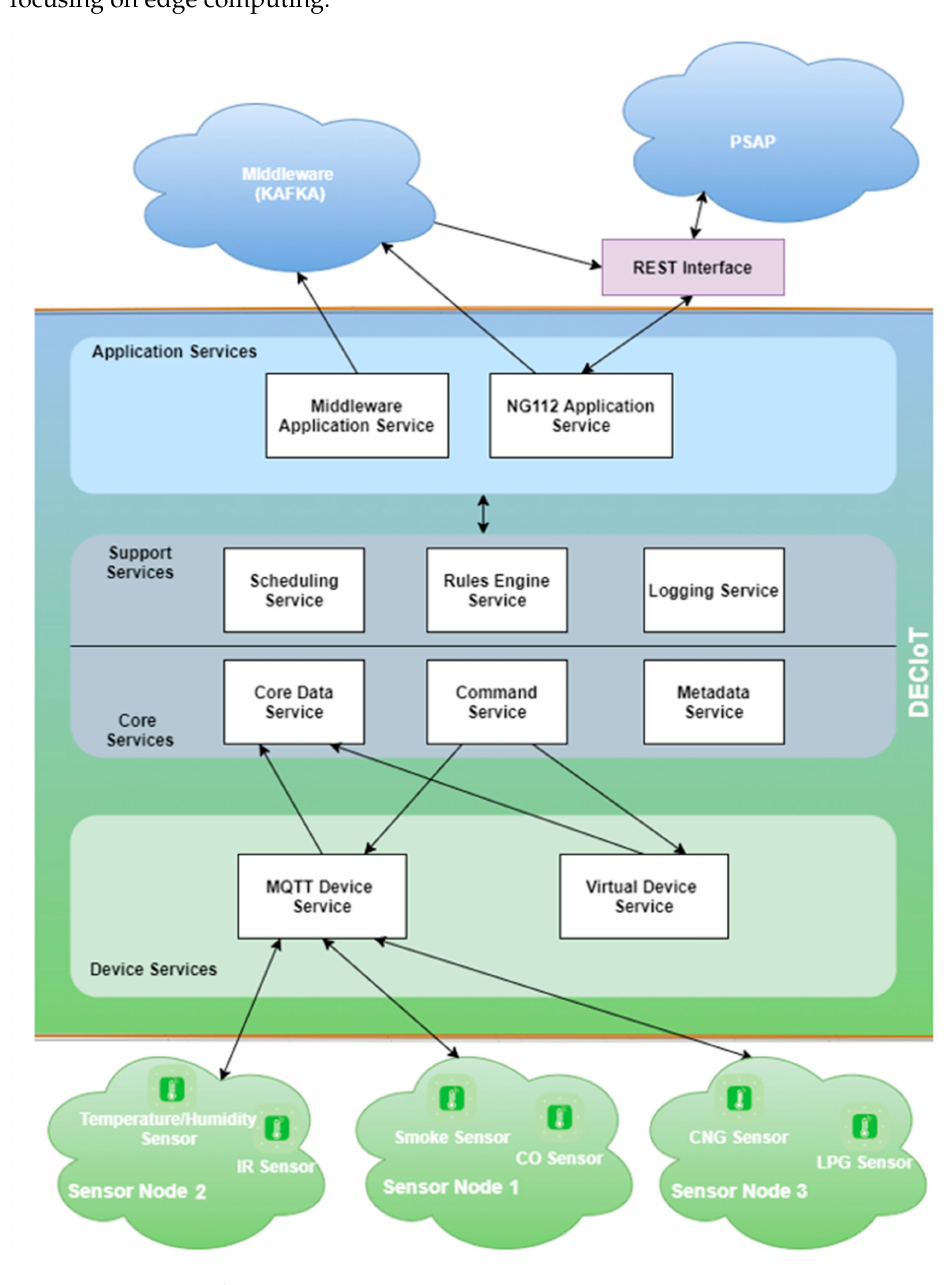
Figure 5. DECIoT